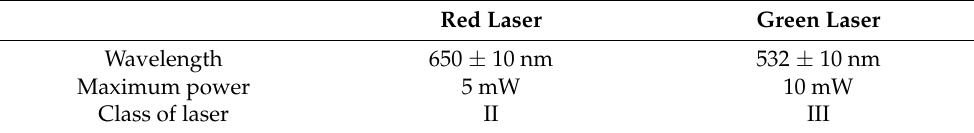
Table 2. Comparison of laser